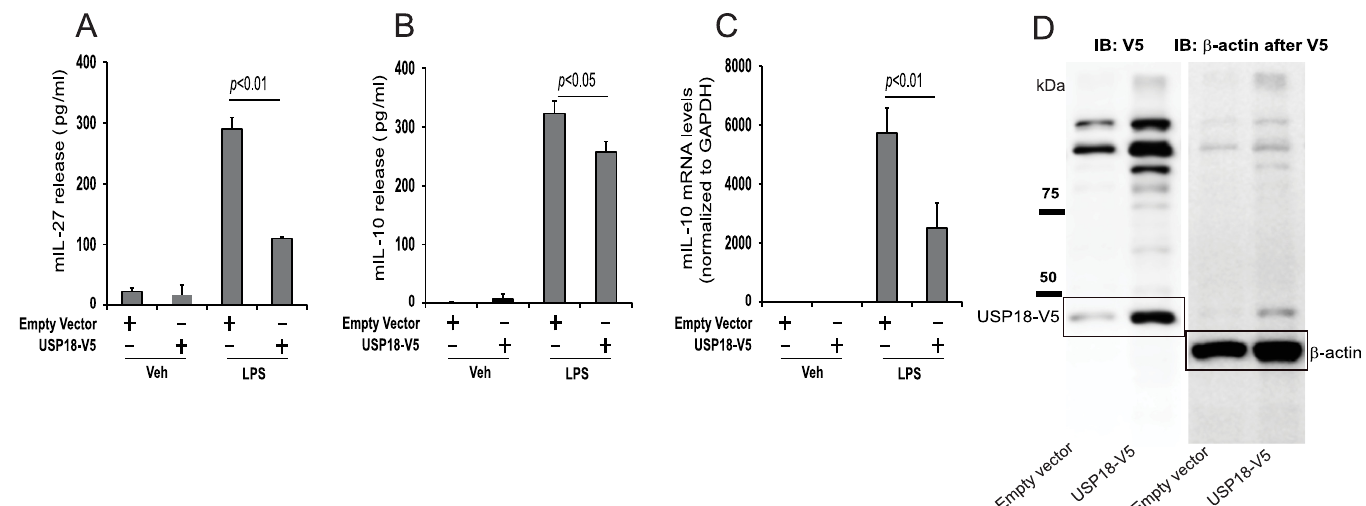
Fig 5. USP-18 overexpression in RAW264.7 cells decreases production of IL-27 and IL-10. RAW264.7 cells were transfected with empty vector or USP-18-V5 (2 μ g) for 48 hours. The cells were then incubated in the presence of LPS (200 ng/ml) or vehicle for 24 hours. Cell supernatants were assessed using ELISA showing (A) decrease in production of mouse IL-27 in USP-18-V5 transfected cells compared to empty vector in the presence of LPS and (B) decreased levels of mouse IL-10 in USP-18-V5 transfected cells after LPS stimulation. RNA was extracted from the RAW264.7 transfected cells and (C) real time quantitative PCR was performed showing decreased IL-10 RNA levels in the USP-18-V5 transfected cells compared to control vector in the presence of LPS. (D) Immunoblotting was performed in the RAW264.7 cells transfected with empty vector or USP-18-V5 (expected band size ~45 kDa) and assayed for V5 tag protein amount. β -actin detection was used as loading control.